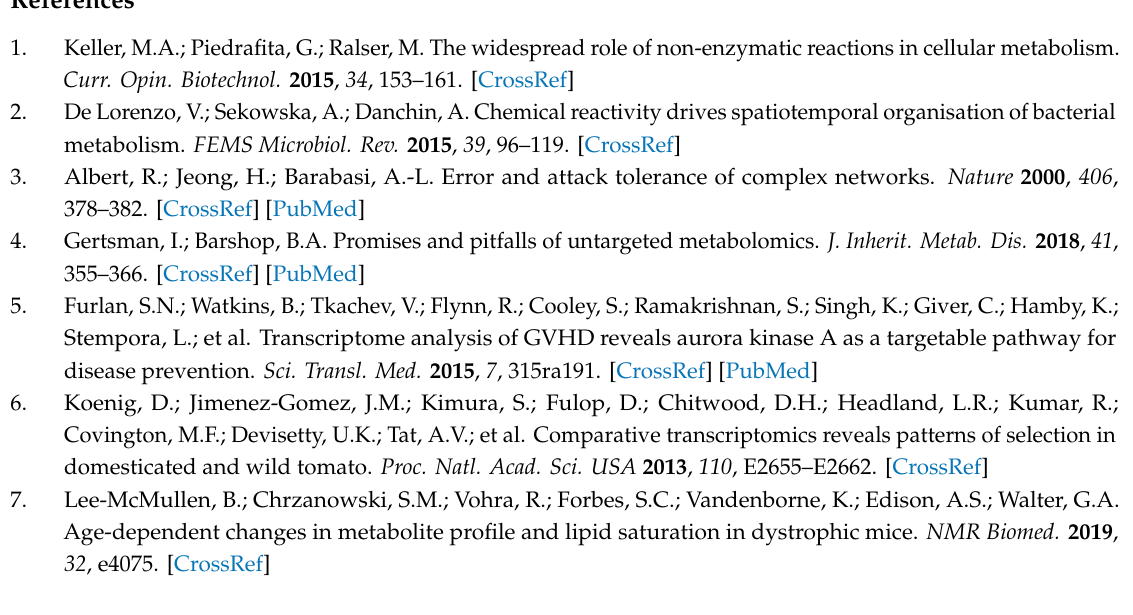
Figure S1: Nicotinate mononucleotide identification by sample spiking, Figure S2: Representative 2D J-RES spectrum, Table S1: Identified metabolites and corresponding confidence levels, Table S2: KEGG pathways represented by di ff erentially up-regulated genes in S. enterica ridA mutants, Table S3: KEGG pathways represented by di ff erentially down-regulated genes in S. enterica ridA